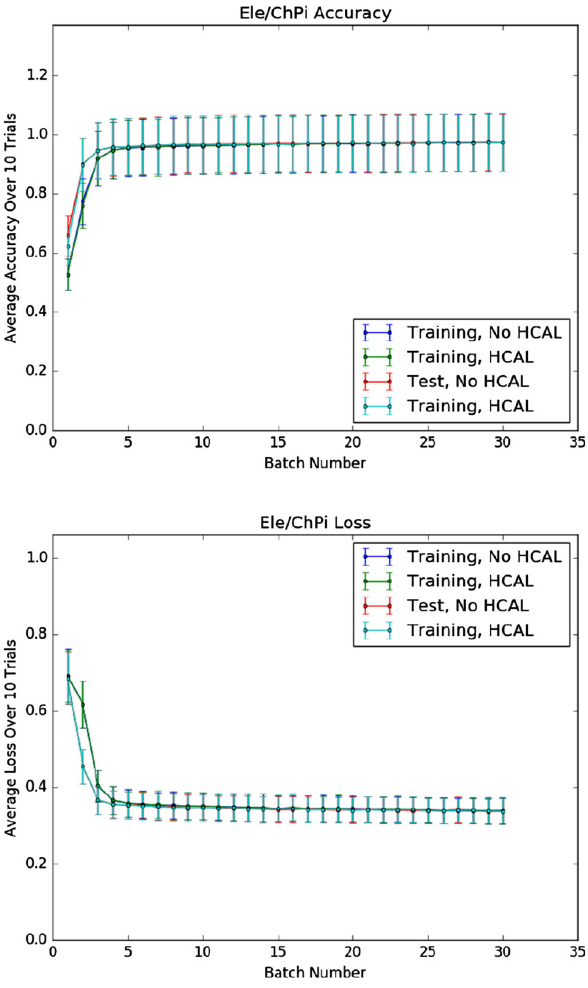
Fig. 30 Accuracy and loss curves for electron/charged pion classifica- tion, with and without HCAL cells, using best DNN architecture